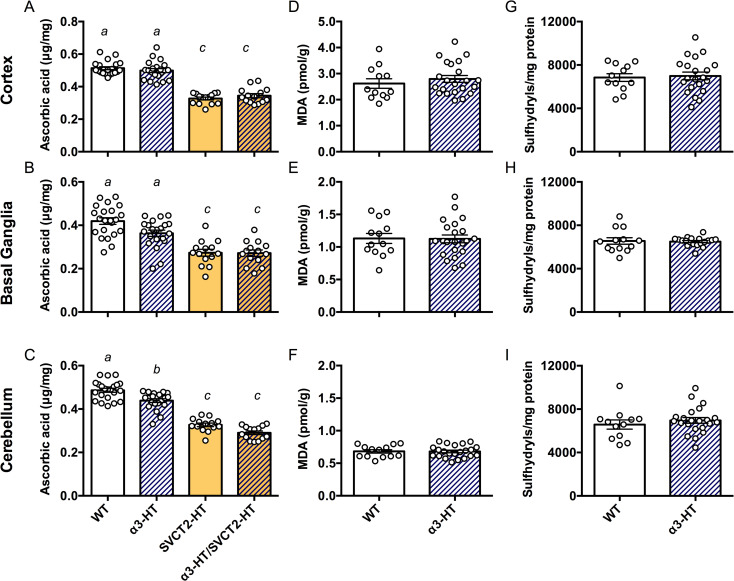
Contents of ASC and oxidative stress marker molecules in parts of adult mouse brains.The ASC content in different regions (the cortex, basal ganglia, and cerebellum) in brains isolated from 2- to 4-month-old adult mice of WT, α3-HT (Atp1a3 heterozygous knockout), SVCT2-HT, and α3-HT/SVCT2-HT, measured by HPLC with chemical detection. A. Cortex. B. Basal ganglia. C. Cerebellum. Bars with different letters are significantly different, as determined by Tukey’s post hoc test. a vs. b, P<0.05; a vs. c and b vs. c, P<0.001. Oxidative stress was estimated by measuring malondialdehyde (MDA) and sulfhydryl levels, in the cortex (D and G), basal ganglia (E and H), and cerebellum (F and I). Statistical analysis by Student’s t-test revealed no significant difference in MDA and sulfhydryl levels between WT and α3-HT mice. N = 14–22 mice per group.